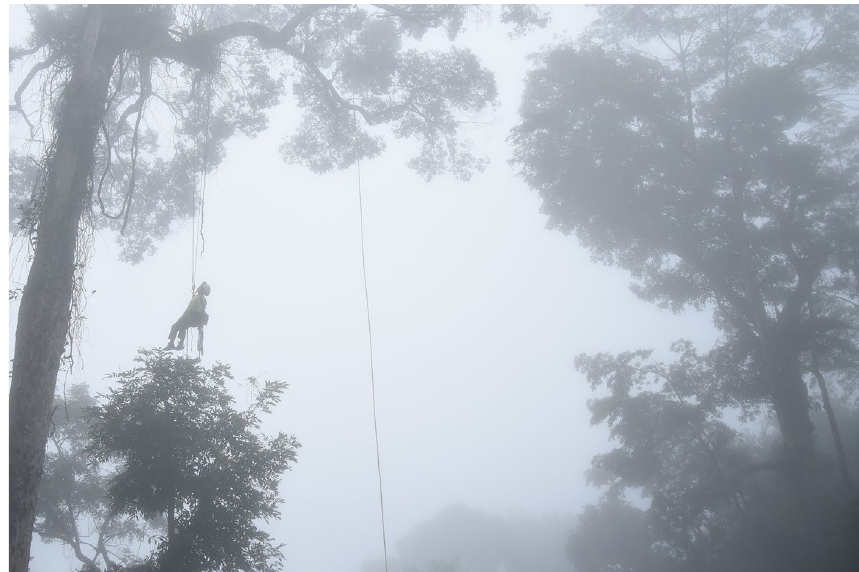
Figure 6. Installation of the canopy bridge by professional tree climbers, taken on 06 December 2015. Photograph taken by C.F.M.